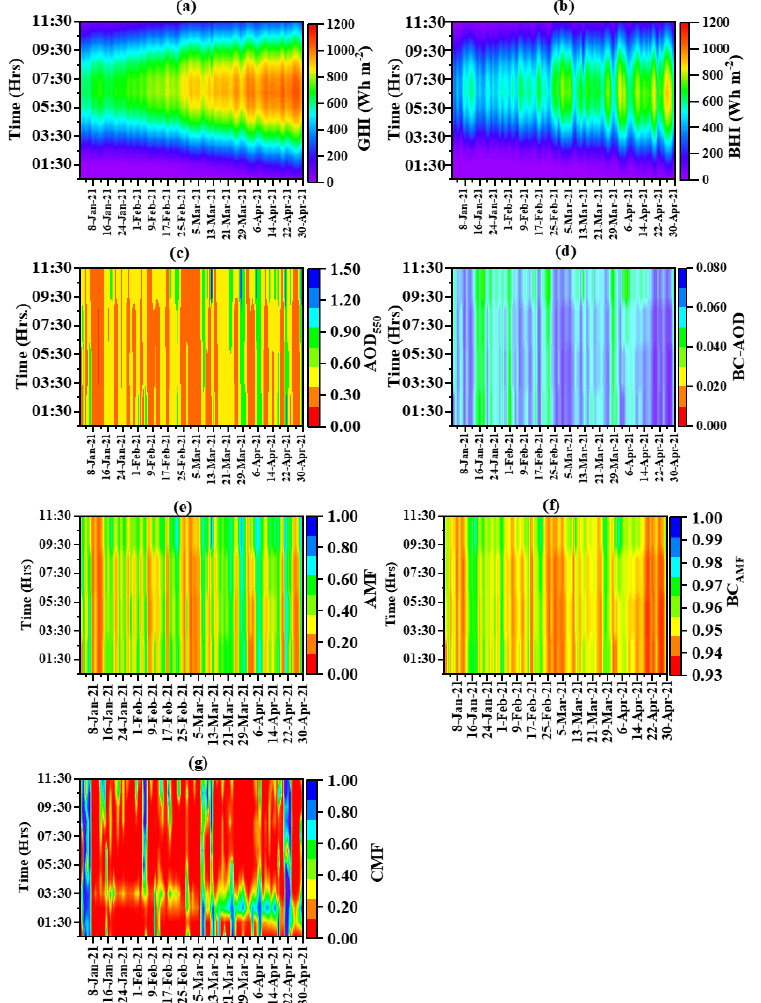
Figure 9. Weekly diurnal variation of GHI ( a ), BHI ( b ), AOD 500 ( c ), BC-AOD ( d ), AMF ( e ), BC AMF ( f ), and CMF ( g ).